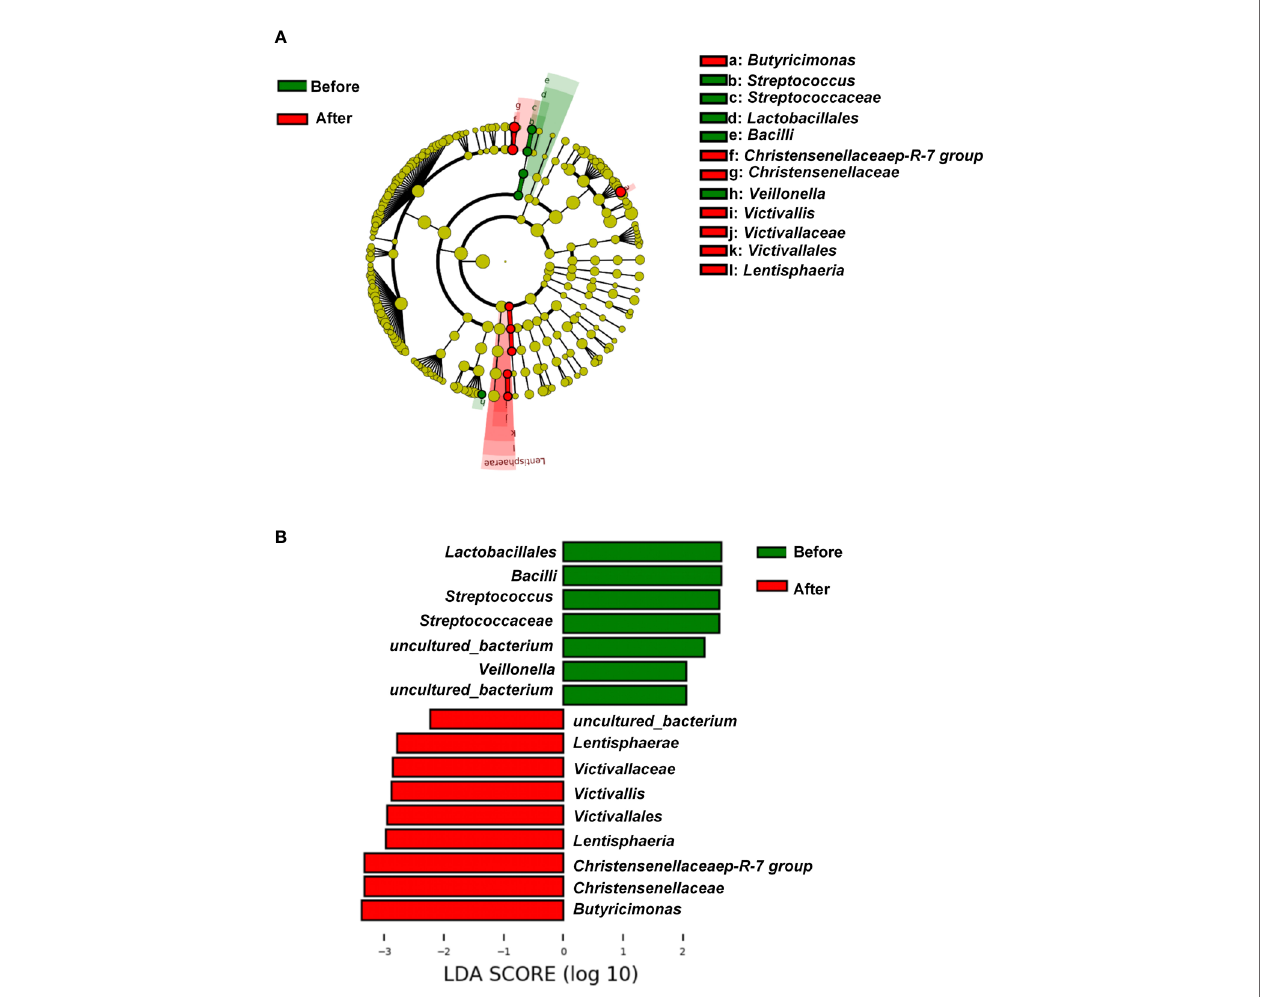
FIGURE 3 | Linear discriminant analysis effect size before and after diet and exercise intervention. (A) Cladogram of the gastric microbial taxa associated with individuals before and after diet and exercise intervention. Taxa higher in relative abundance before the intervention are in green, and those higher after the intervention are in red. (B) Histogram of the linear discriminant analysis (LDA) scores for differentially abundant taxonomic features before and after the intervention. Signi fi cance obtained by LDA effect size at P < 0.05, (Kruskal – Wallis test) and LDA score